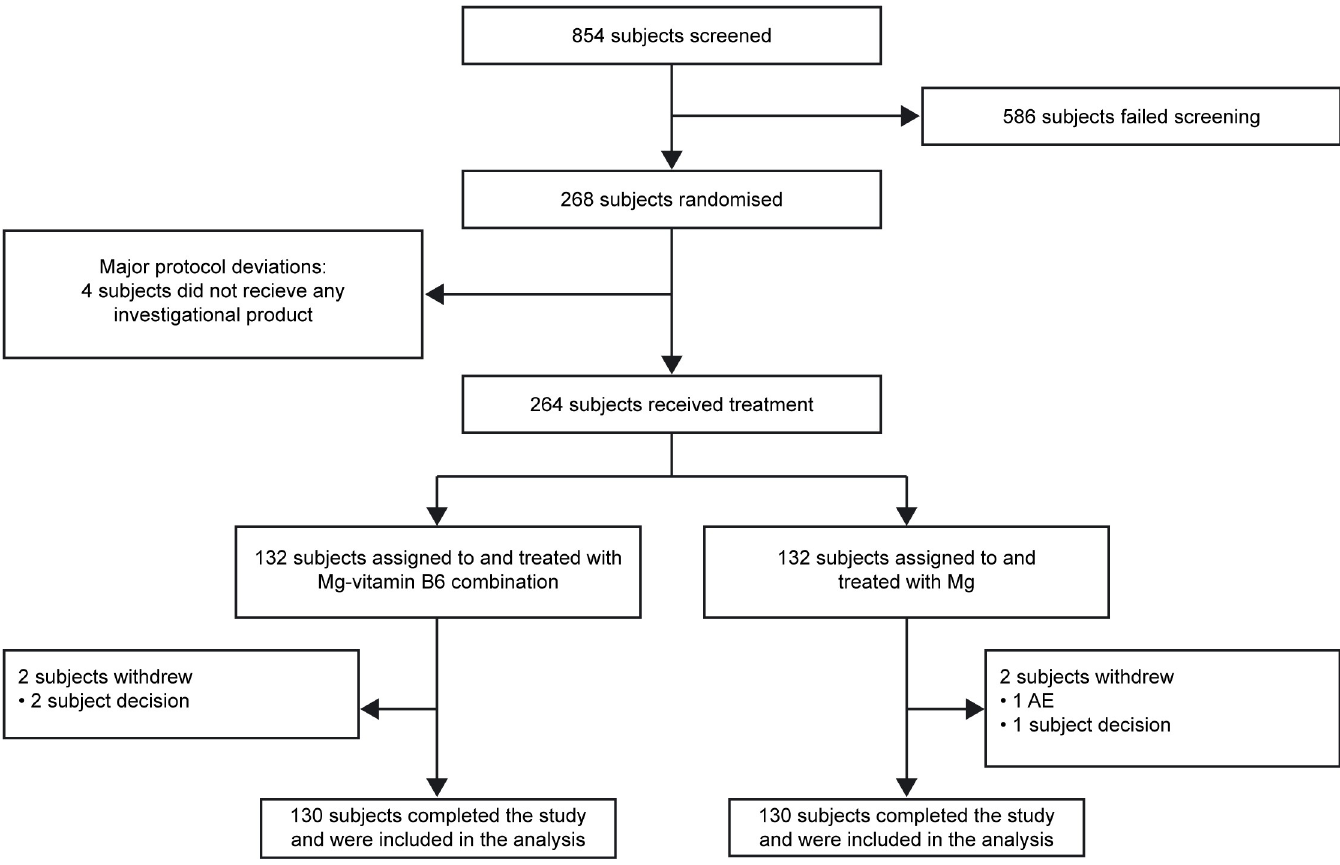
Fig 1. CONSORT flowchart. AE, adverse event; Mg,